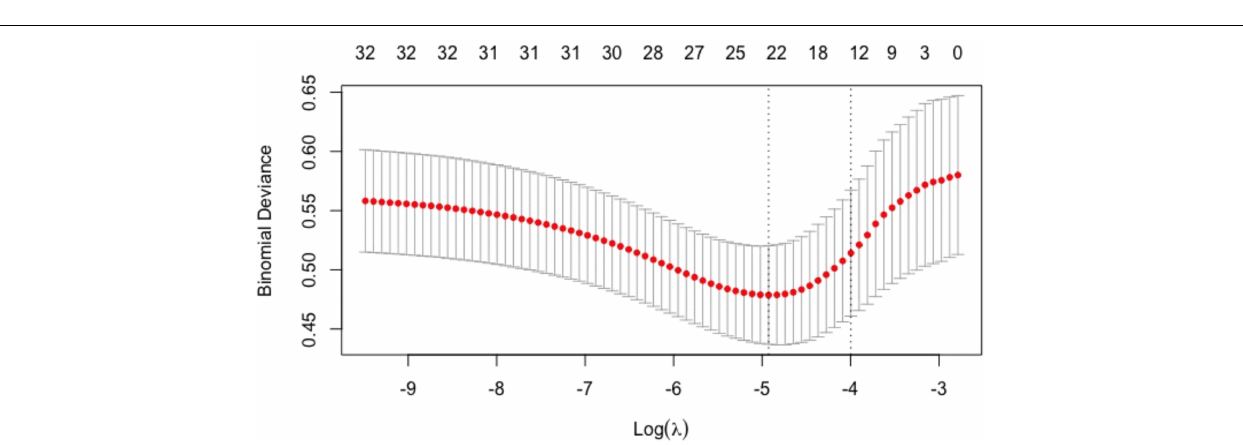
FIGURE 2 | Tuning parameter ( λ ) selection in the Lasso regression model. Models were fitted using cross-validation, and then, the optimal λ value was selected to have a more accurate estimate of the performance of the model. For each λ value, around the mean of the target parameter shown in the red dot, we could obtain a confidence interval of the target parameter. The two dashed lines indicated two particular λ values, namely, the one with the smallest model error, and the one with the best model performance but the smallest number of independent